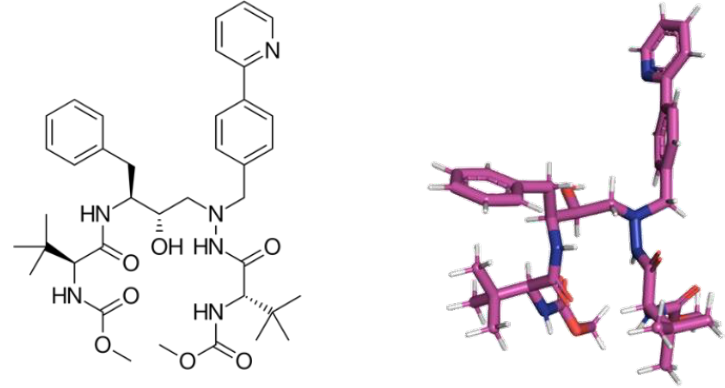
Figure 1. The 2D- and 3D-chemical structure for atazanavir (ATV).